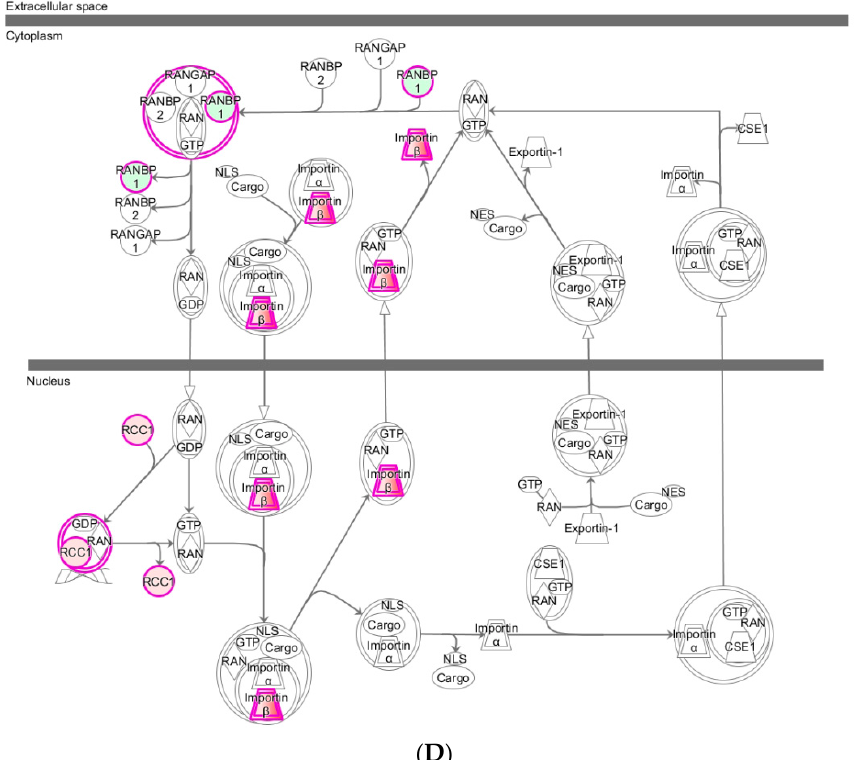
Figure 3. Regulation of the canonical Ran signaling pathway in S. cerevisiae response to oxidants at 3 min by ( A ) H 2 O 2 and ( B ) CHP. Regulation of the canonical Ran signaling pathway in S. cerevisiae response to oxidants at 3 min by ( C ) menadione and ( D ) diamide. Networks were constructed using IPA ® based on global untargeted proteomics analysis using label-free quantification relying on precursor ions of tryptic peptides based on high-resolution (Orbitrap) mass spectrometry. Regulation of the pathways and individual components are indicated by color: green for protein downregulation, red for protein upregulation, blue for pathway inhibition, and orange for pathway activation.